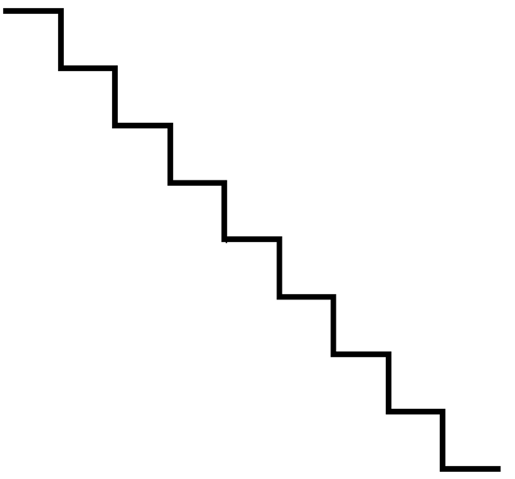
Figure 1. Scheme of CNT